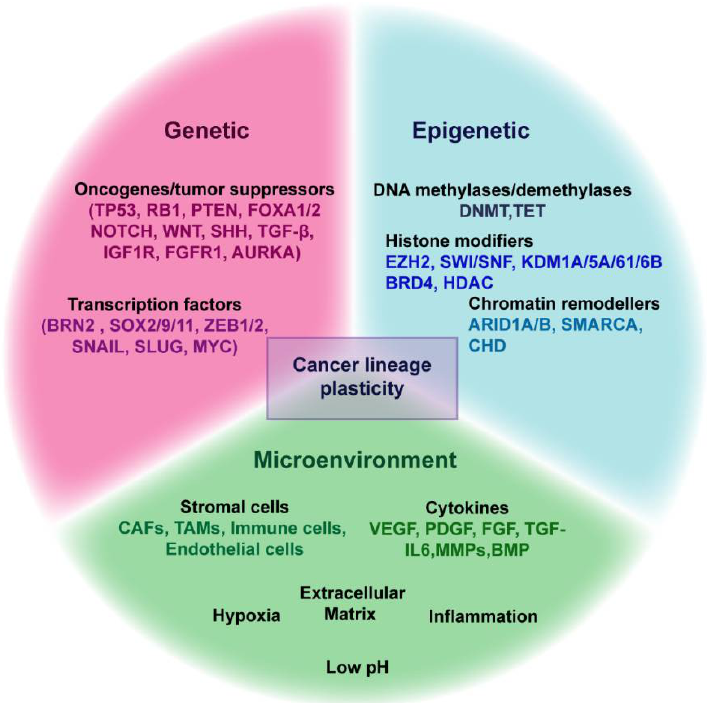
Figure 2. Genetic, epigenetic and microenvironmental factors involved in regulating lineage plasticity. The genetic factors include the loss of tumor suppressors and gain of oncogenes and overexpression of several transcription factors, eventually resulting in the enabling of the cellular reprogramming. In addition, altered expression of epigenetic modulators and microenvironmental components also play an important role in facilitating the switching of cellular identity in response to various stresses.